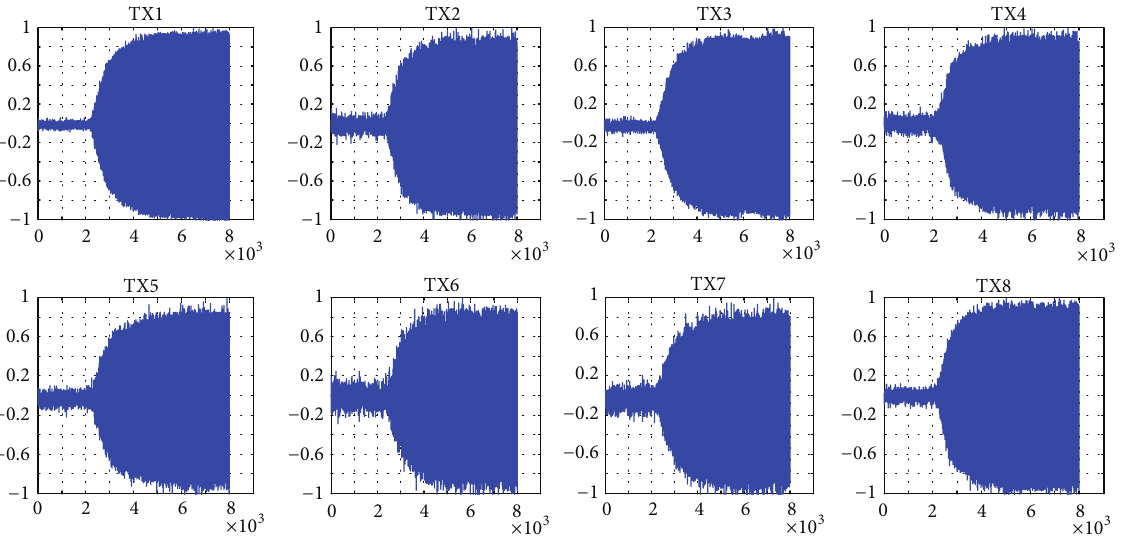
Figure 3: The transient waveforms of 8 different wireless transmitters.